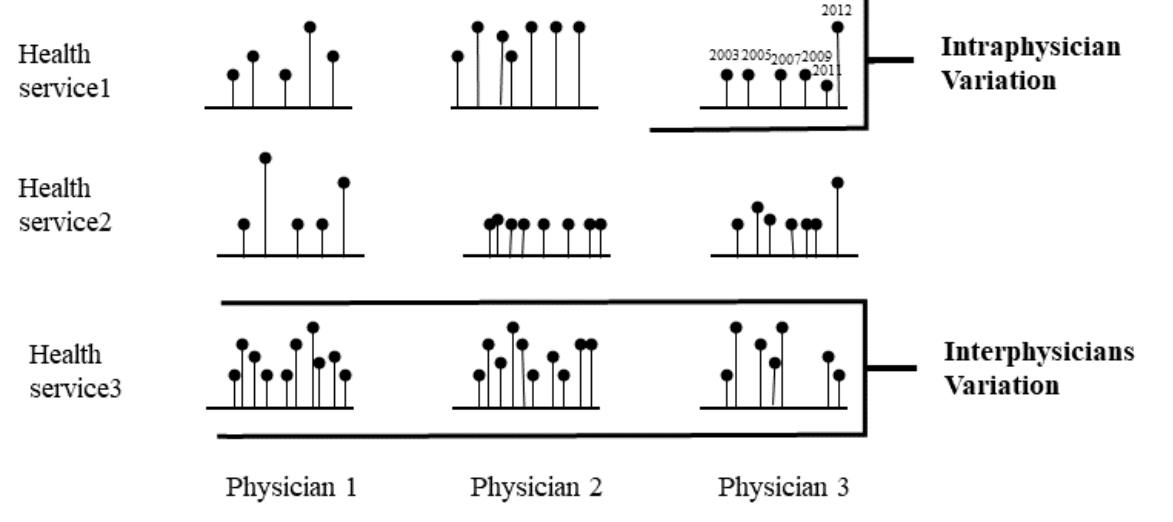
Figure 1. Two types of